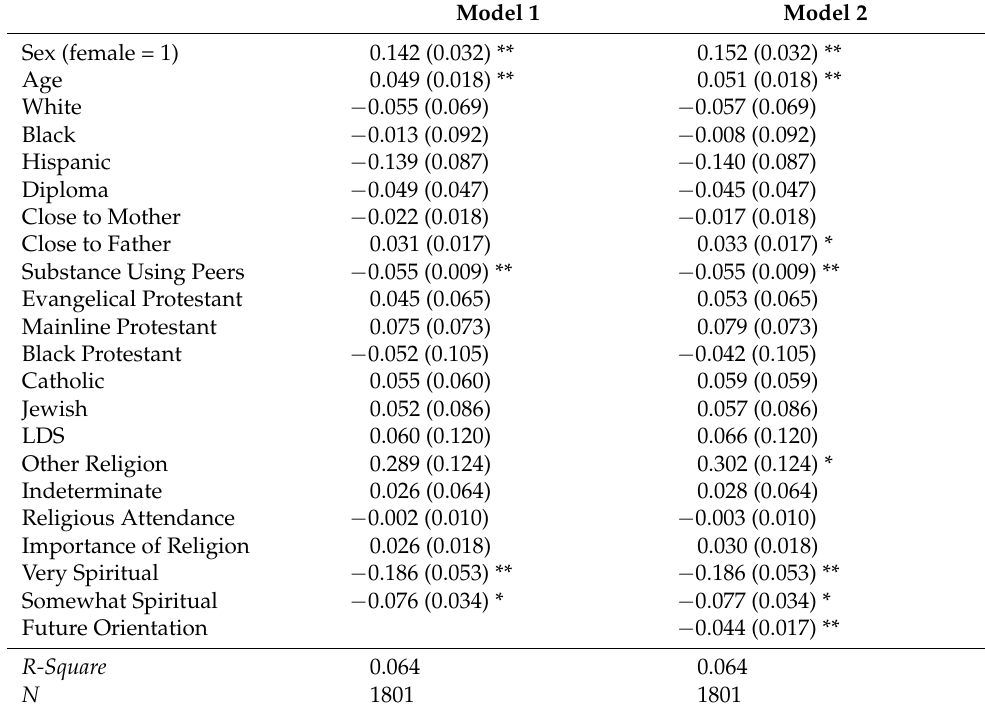
Table 2. OLS Regression of Religiosity, Future Orientation, and Self-control (Standard